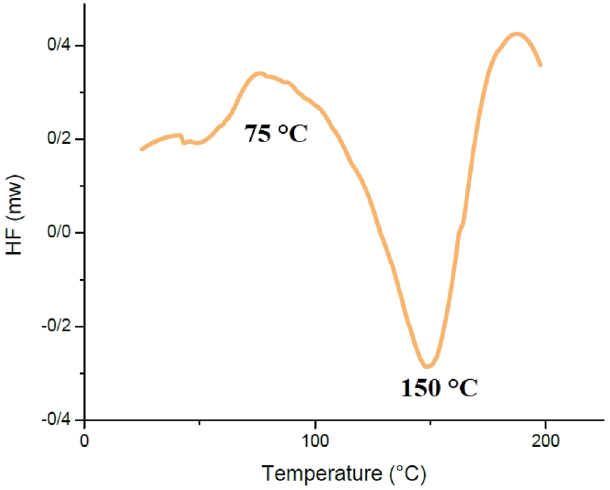
Figure 17. DSC diagram of cPNIPAAM produced in a homogeneous phase of SC-CO2 and co-solvent of DMF.